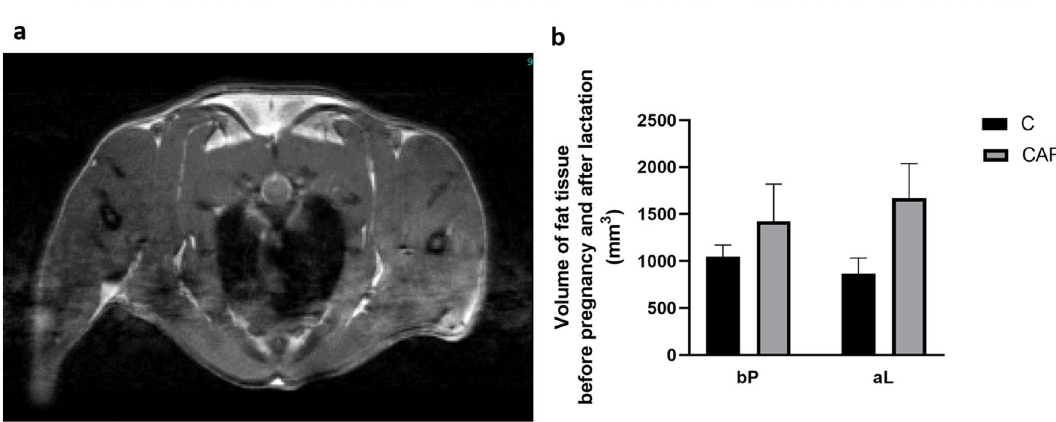
Figure 2. Magnetic resonance image. ( a ) A representative magnetic resonance image from C group; white arrow points an area of measurement of fat tissue; ( b ) volume of fat tissue measured before pregnancy and after lactation; bP before pregnancy (p = 0.42), aL after lactation (p =